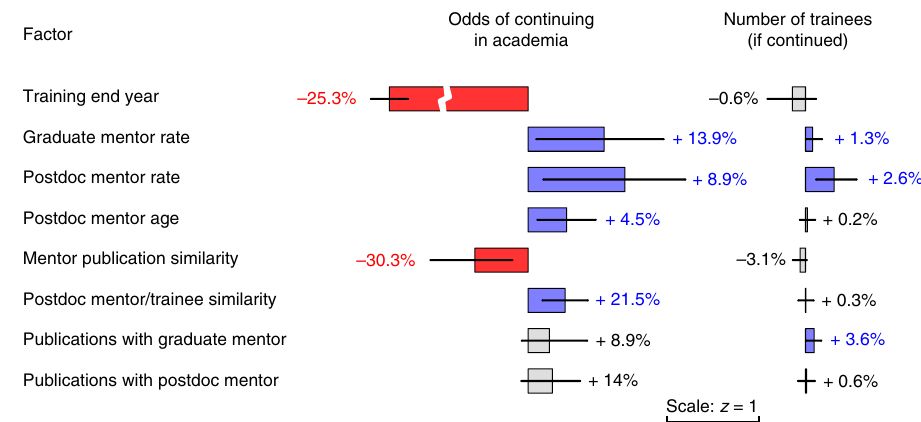
Fig. 4 Modeled effects of variables for continuing in academia (left column) and for training rate when continuing (right column). Percent values indicate the change in the odds of continuing in academia (left) and in the training rate (right) following an increase of one unit for each factor. Error bars show the 95% bootstrapped con fi dence interval for the modeled effects. The bars and error bars are plotted in z-scored units (cf. scale bar), enabling comparison of their effects despite their different scales. Signi fi cant changes are color-coded and the associated percentages are shown in bold. For example, the interpretation of “ Postdoc mentor rate ” is as follows: ceteris paribus, an increase of 1-point on the postdoc mentor proliferation scale (i.e., one more trainee per decade) improves the odds of the protégé to fi nd a permanent position by 8.9%, and this effect is statistically signi fi cant. The long-term effect of this change is also signi fi cant, and the protégé ‘ s proliferation rate is then increased by 2.6%